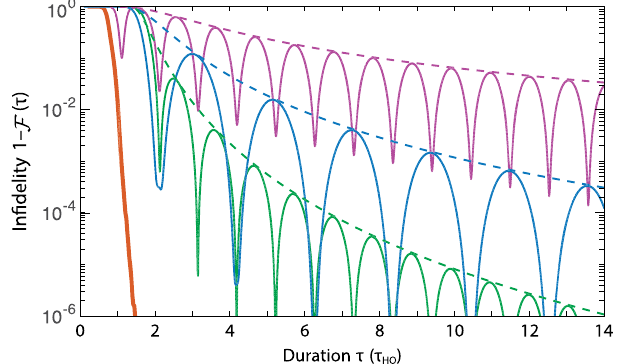
FIG. 8. Transport protocols compared. Infidelity computed numerically for the same conditions of Fig. 2 and T ⊥ ¼ 0 using different transport protocols. From top to bottom: a linear transport ramp (purple), parabolic control (blue), adiabatic con- trol (green), optimal quantum control (thick red). The dashed lines represent the envelope functions according to Eqs. (I1a), (I1b), and